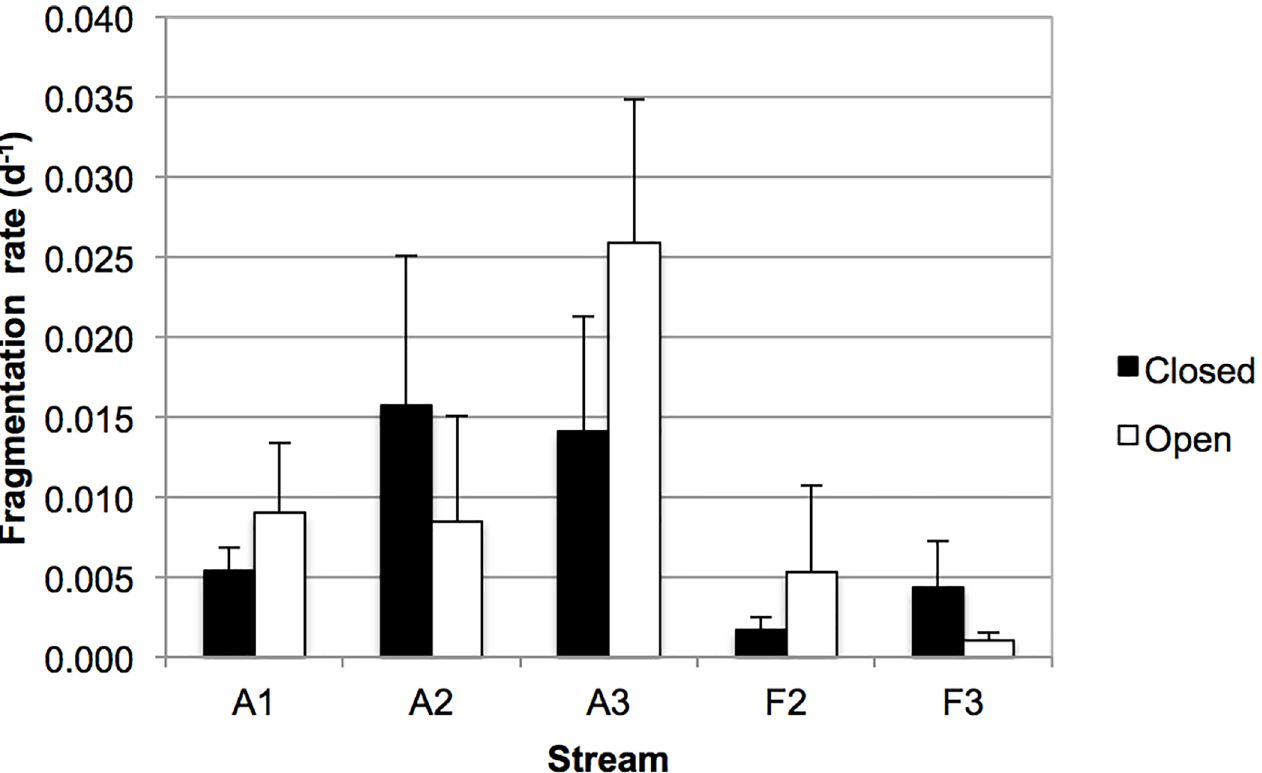
Fig 4. Fragmentation rate of leaves in bags. Black columns, closed reaches, white columns, open reaches of agricultural (A) and forest (F) streams. Values are arithmetic means, error bars show standard